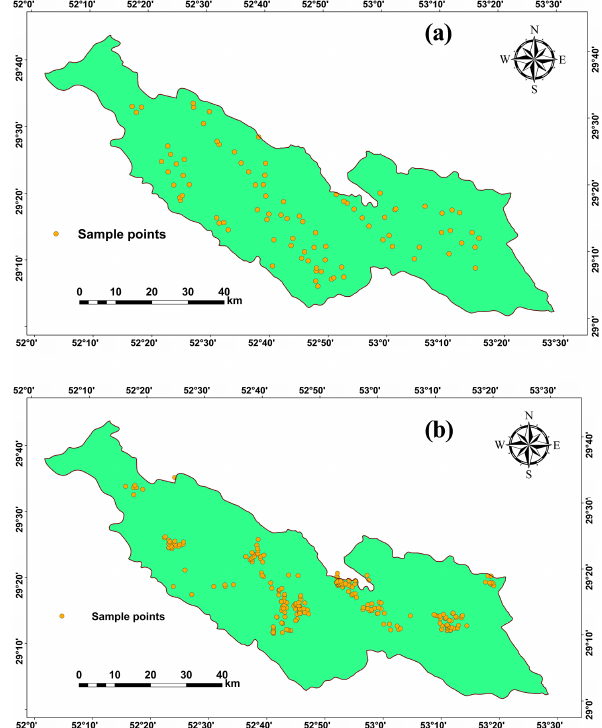
Figure 4. Position of sample points for (a) water and (b) soil